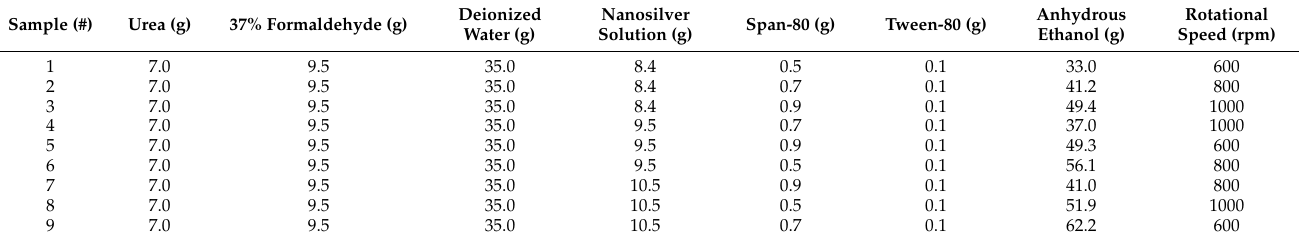
Table 3. Orthogonal test schedule.